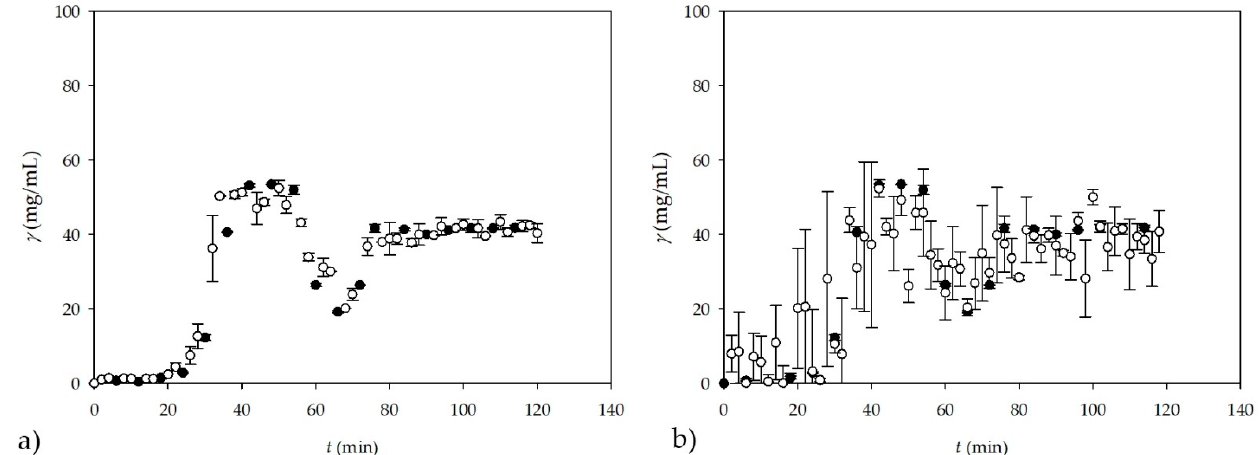
Figure 9. On-line measurement of glycerol concentration performed as ( a ) prediction by ANN based on NIR spectroscopy for experiments carried out in a +-shape microreactor for two different concentrations of oil in inlet stream and ( b ) prediction by subsampling ANN based on NIR spectroscopy for experiments carried out in a +-shape microreactor for two different concentrations of oil in inlet stream ( ● — theoretical glycerol calculated from experimental data ○ — ANN predictions).